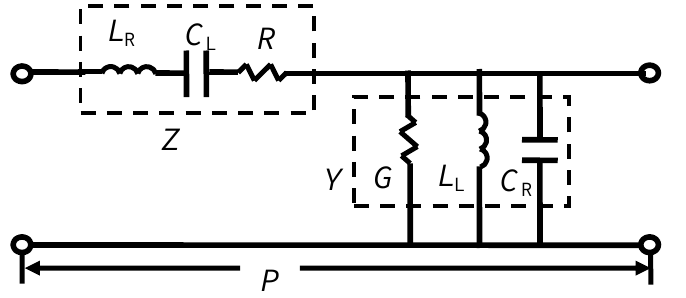
Figure 1. Equivalent circuit model of a unit cell of a general metamaterial CRLH-TL (active scenario: negative R and/or negative G